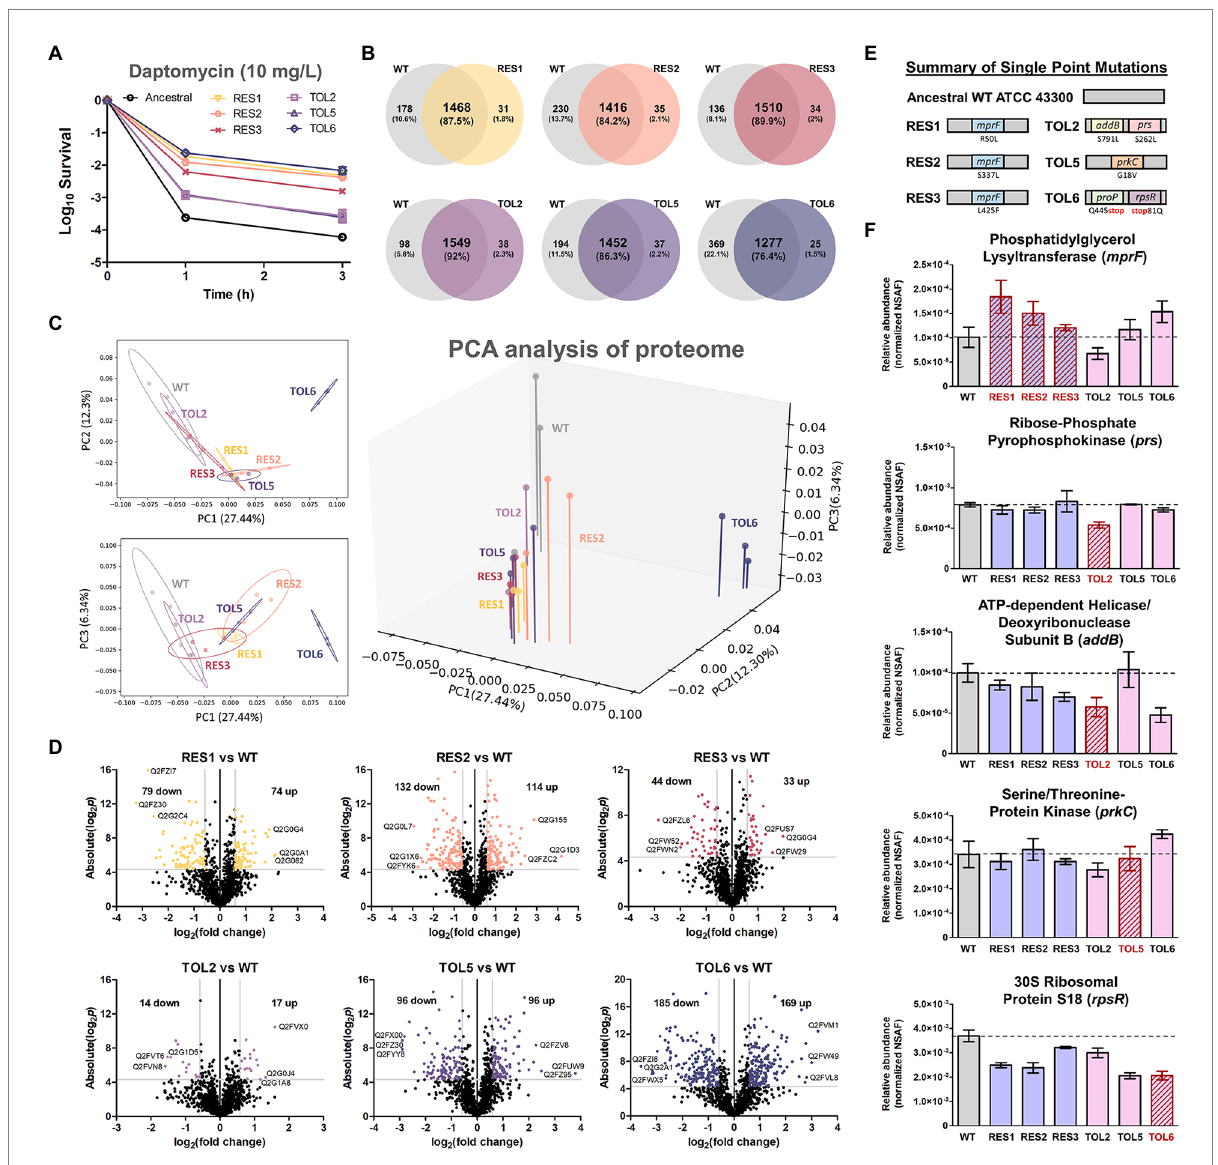
FIGURE 1 Proteome profile comparison between the tolerant/resistant strains and the ancestral strain. (A) Time-kill curve of the ancestral strain, resistant strains (RES1, RES2, RES3), and tolerant strains (TOL2, TOL5, TOL6) upon daptomycin treatment (10 mg/l) for 3 h (mean ± s.e.m., n = 3). (B) Venn diagrams for proteome comparison of the resistant strains (RES1, RES2, RES3) and tolerant strains (TOL2, TOL5, TOL6) with the ancestral strain. (C) Principal Component Analysis (PCA) of proteomes of the tolerant/resistant strains and the ancestral strain. Projections of PC1 versus PC2, PC1 versus PC3, and a three-dimensional projection of PC1, PC2, and PC3 are shown. Shaded circles represent 95% confidence intervals based on correlation matrices of the three replicates of each sample. (D) Volcano plots of the resistant strains (RES1, RES2, RES3) and tolerant strains (TOL2, TOL5, TOL6) compared to the ancestral strain. Differentially expressed proteins (DEPs) are defined to be those with p values below 0.05, and absolute fold change greater than 1.5, corresponding to the colored dots. The protein IDs of the most down-regulated and up-regulated proteins are shown. (E) Summary of single point mutations identified in the resistant and tolerant strains, with the respective gene and amino acid substitution. Details about the mutations can be found in Supplementary Table S1. (F) The expression level of the genes that are mutated in the evolved strains. Relative abundance of the proteins phosphatidylglycerol lysyltransferase (MprF), ribose-phosphate pyrophosphokinase (Prs), ATP- dependent helicase/deoxyribonuclease subunit B (AddB), serine/threonine protein kinase (PrkC), and 30S ribosomal protein S18 (RpsR) among the ancestral strain and evolved strains, measured by label-free quantitative proteomics using spectral counting, where the y -axis is the normalized spectral abundance factor (NSAF) values (mean ± s.e.m., n = 3). Strains that express the mutated proteins were marked with red